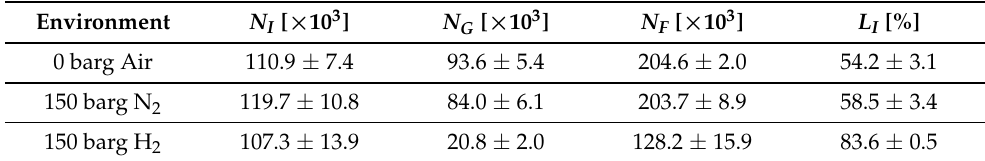
Figure 5. Bar graph of the number of cycles spent in the crack initiation phase ( N I ) and the growth phase ( N G ), and the total number of cycles until failure ( N F ) of the base metal specimens. The different environments tested are shown with distinct colors. The single and double hatched bars represent the number of cycles spent in the initiation and growth phase, respectively. Error bars are standard deviations. Table 3. An overview of the base metal fatigue results, presenting the number of cycles spent in the crack initiation phase ( N I ), the growth phase ( N G ), the cycles until failure ( N F ) and percentage of lifetime spent in the crack initiation phase ( L I ). Errors are standard